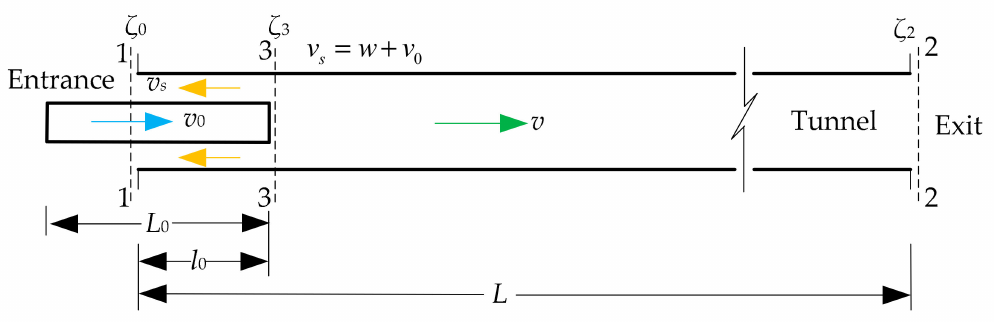
Figure 2. Schematic of train entering tunnel phase.